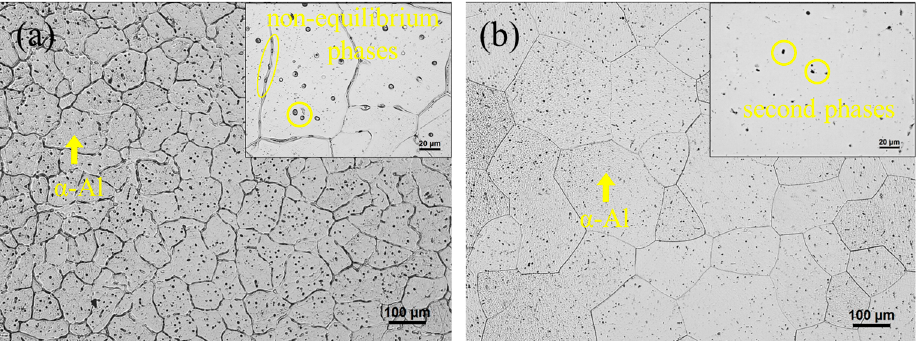
Figure 2. Effect of homogenization on Al-0.5Mg-0.4Si-0.1Cu alloy: ( a ) as-cast, ( b ) homogenized.